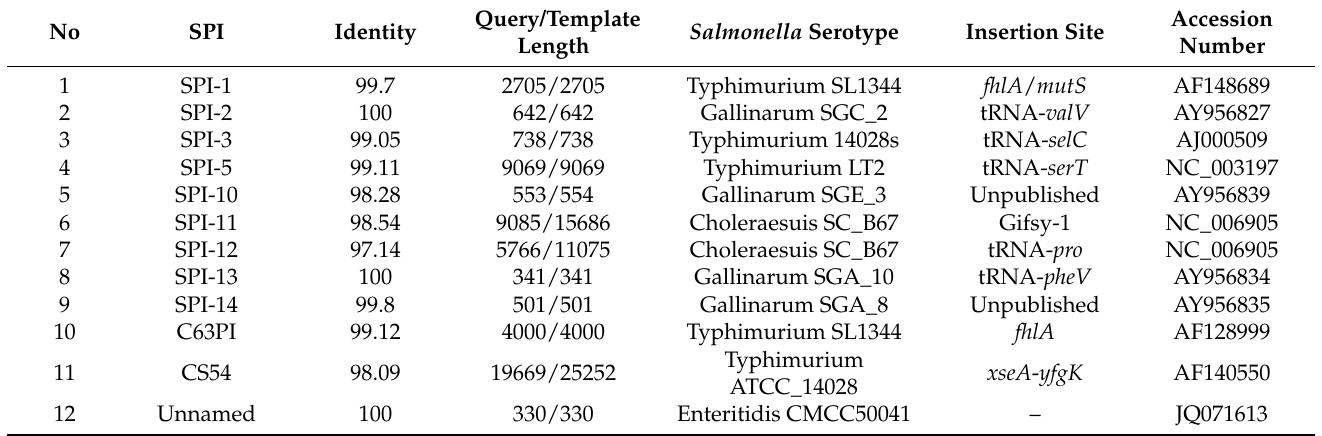
Table 5. Pathogenicity islands identified in Salmonella SE3.